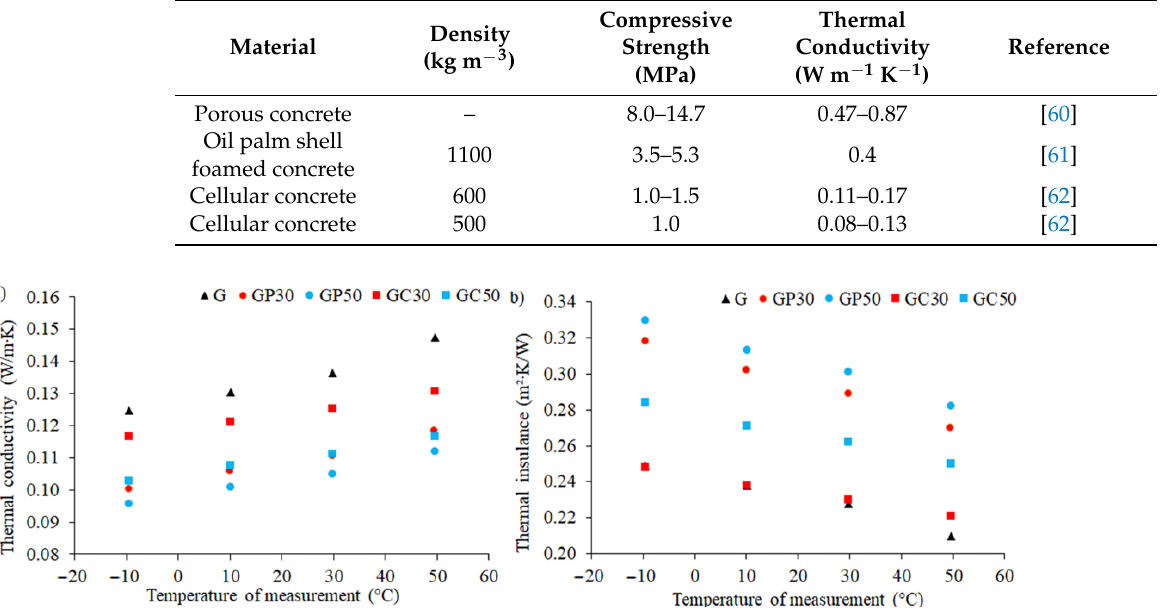
Figure 4. Thermal conductivity ( a ) and thermal insulance ( b ) measured at different temperatures for foamed geopolymer and composite materials with different compositions.